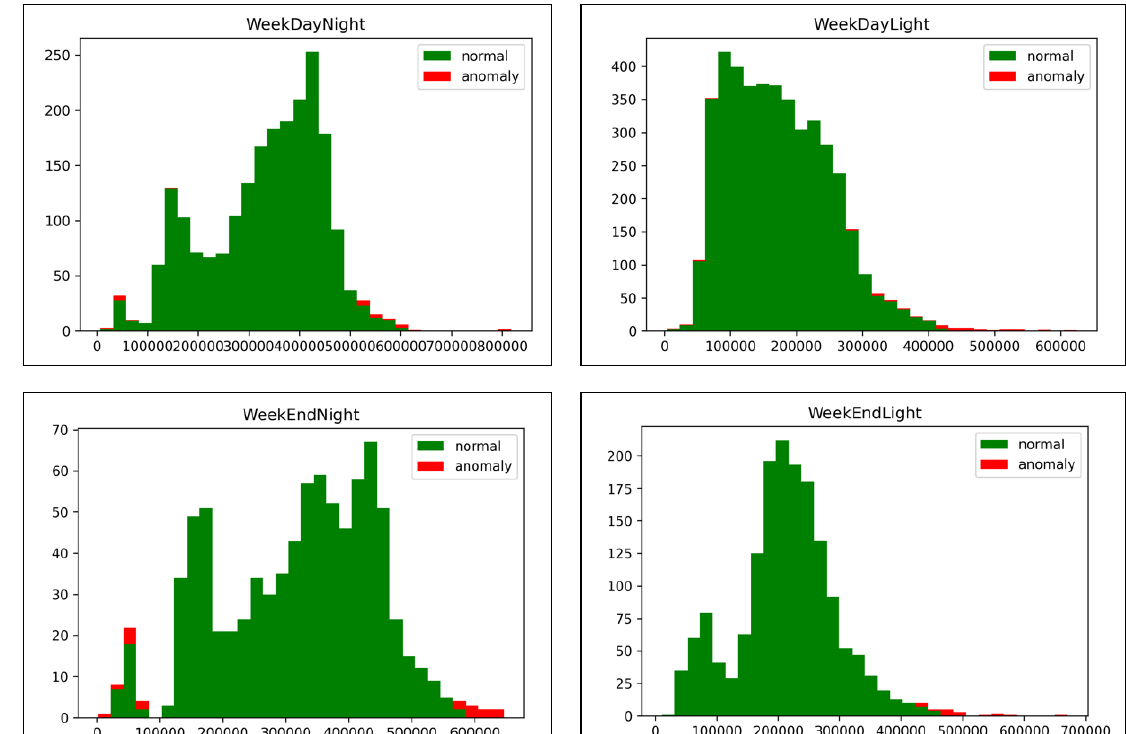
Figure 11. Plot frequency of normal and anomaly data detected by